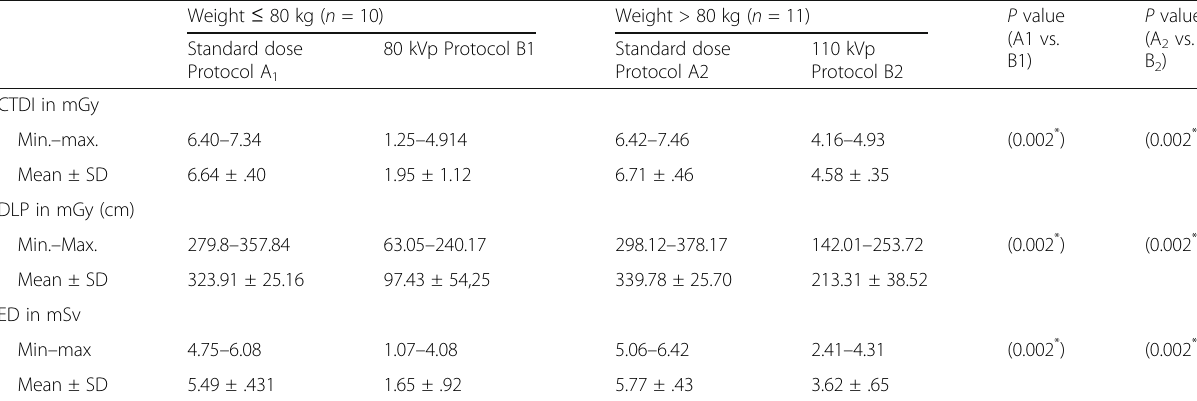
Table 1. The 21 patients underwent standard-dose CT urography protocol A and additional limited scan to the pelvis at delayed phase protocol B. scan protocols were subdivided into 4 groups protocol A Table 2 Descriptive analysis of the studied cases according to CTDI in mGy, DLP in mGy-cm and ED in